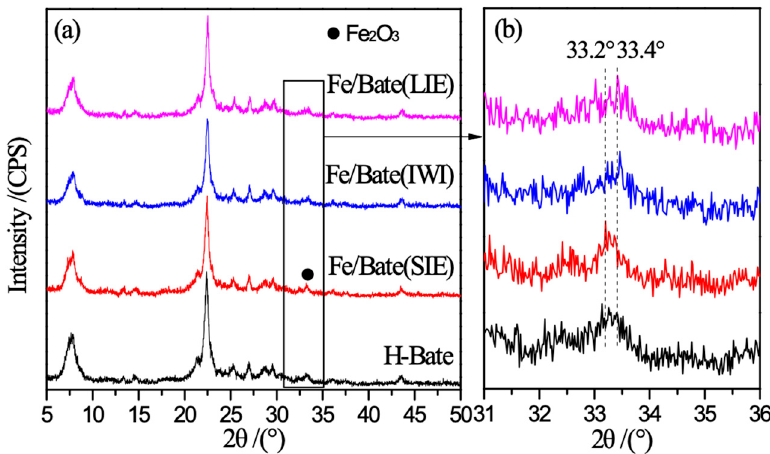
Figure 2. XRD diffractograms of H-Beta and Fe/Beta catalysts, ( a ) a wide scan in the 2 θ region of 5–50° and ( b ) an enlarged view in the 2 θ region of 31–36°.